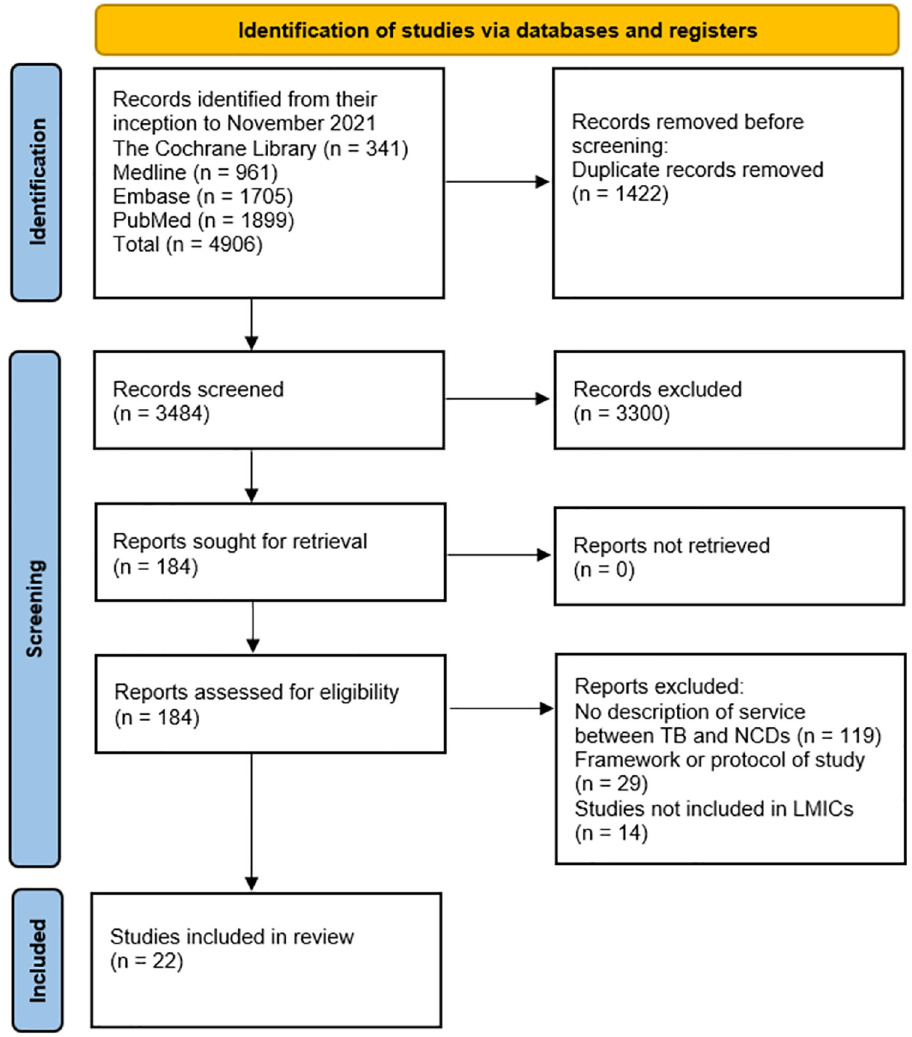
Fig 1. PRISMA 2020 flow diagram of the study selection process. L AU : AbbreviationlistshavebeencompiledforthoseusedthroughoutFigs 1 and 3 : Pleaseverifythatallentriesarecorrect : MIC, low- and middle-income country; NCD, noncommunicable disease; PRISMA, Preferred Reporting Items for Systematic Reviews and Meta-Analyses; TB,